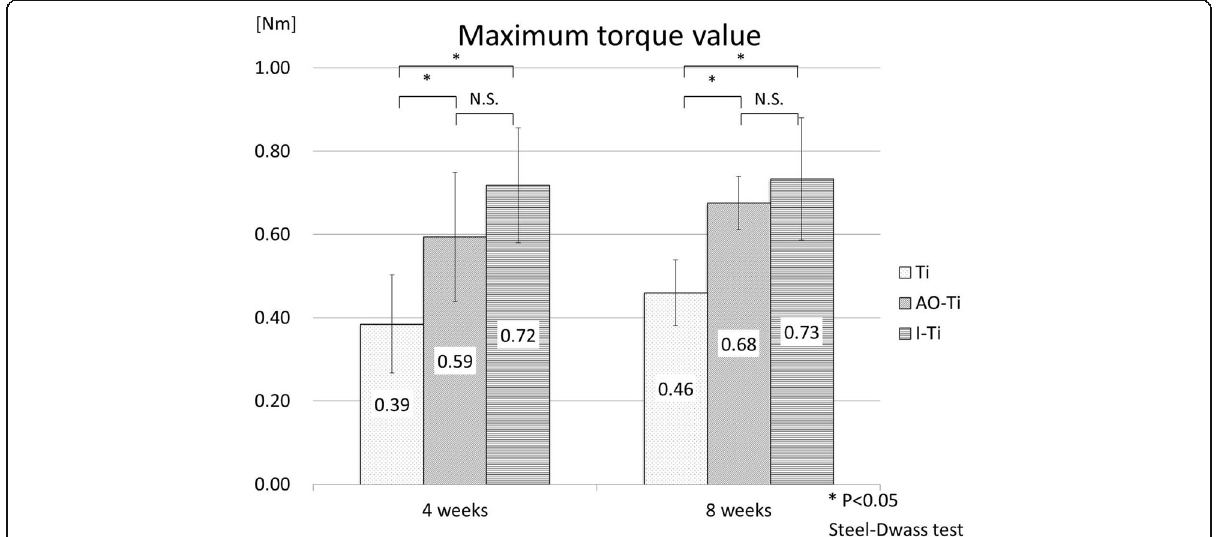
Fig. 6 Results of biomechanical examination (maximum torque value). At 4 and 8 weeks after screw insertion, the maximum torque value of the AO-Ti and I-Ti groups was significantly higher than that of the Ti group ( p < 0.05). There was no significant difference found between the AO-Ti and I-Ti groups